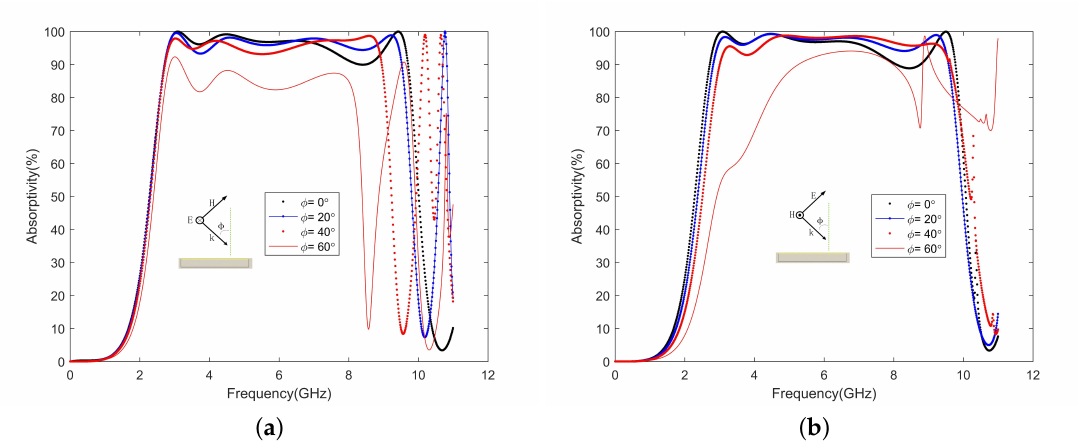
Figure 6. Different incidence angles for ( a ) TE and ( b ) TM